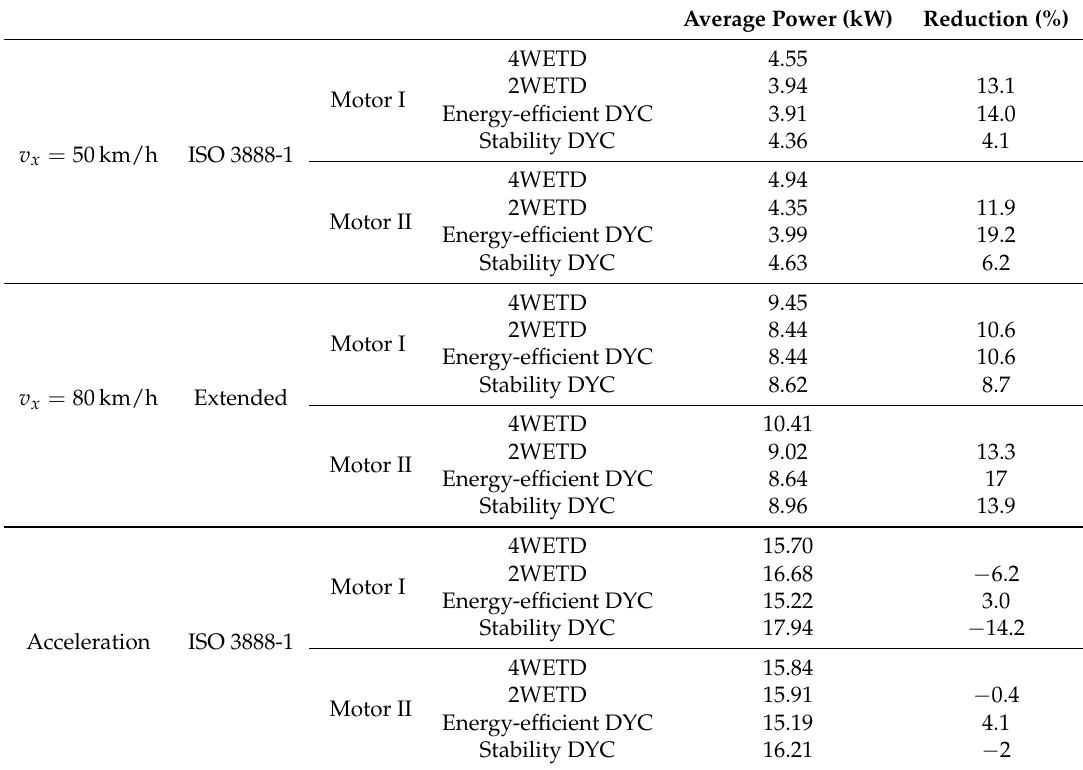
Table 4. Average power consumption and the percentage reduction for the simulated driving tests.